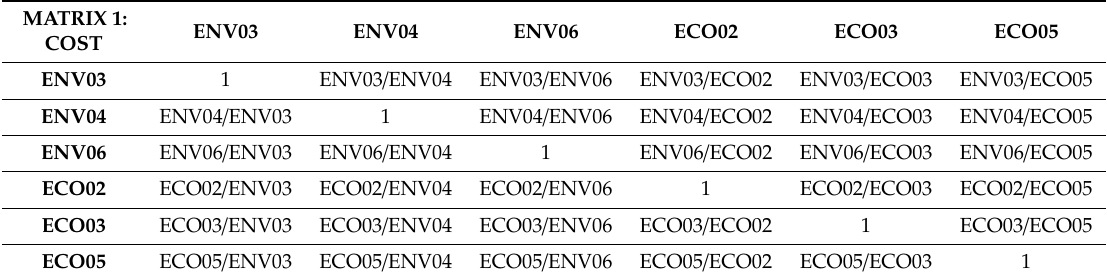
Table 3. Pairwise comparison matrices for Matrix 1 (cost).